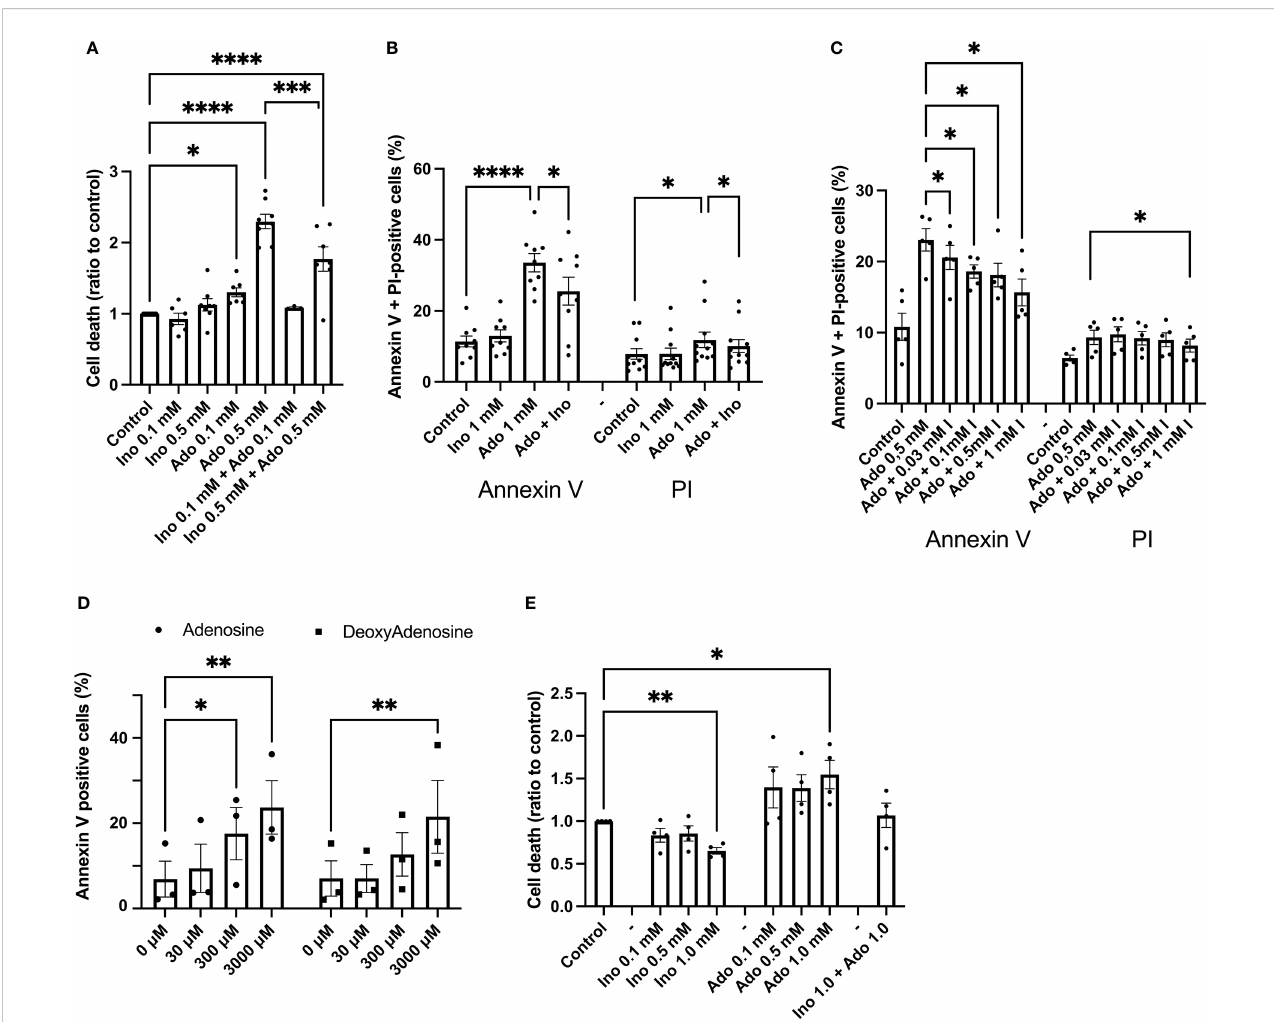
FIGURE 1 Adenosine, but not inosine, increases EndoC-betaH1 and human islet cell death. (A) EndoC-betaH1 cells were incubated for 48h with adenosine (Ado, 0.1 and 0.5 mM), inosine (0.1 and 0.5 mM) or adenosine + inosine. Cells were then stained with PI and analysed by fl ow cytometry. (B) EndoC-betaH1 cells were incubated for 24h with adenosine and inosine (1 mM), and stained with Annexin V + PI for fl ow cytometry analysis. (C) EndoC-betaH1 cells were incubated for 24h with 0.5 mM adenosine in the presence of increasing concentrations of inosine, and analyzed by Annexin V + PI staining and fl ow cytometry. (D) EndoC-betaH1 cells were incubated for 24h with increasing concentrations of adenosine and 2-deoxyadenosine, and analyzed with Annexin V + PI staining and fl ow cytometry. (E) Human islets were incubated for 48h with increasing concentrations of adenosine and inosine, and staining with PI (dead cells) +Hoechst (all cells) followed by fl uorescence microscopic quanti fi cation of PI and Hoechst stain. The PI/Hoechst ratio was calculated as a relative measure of islet cell